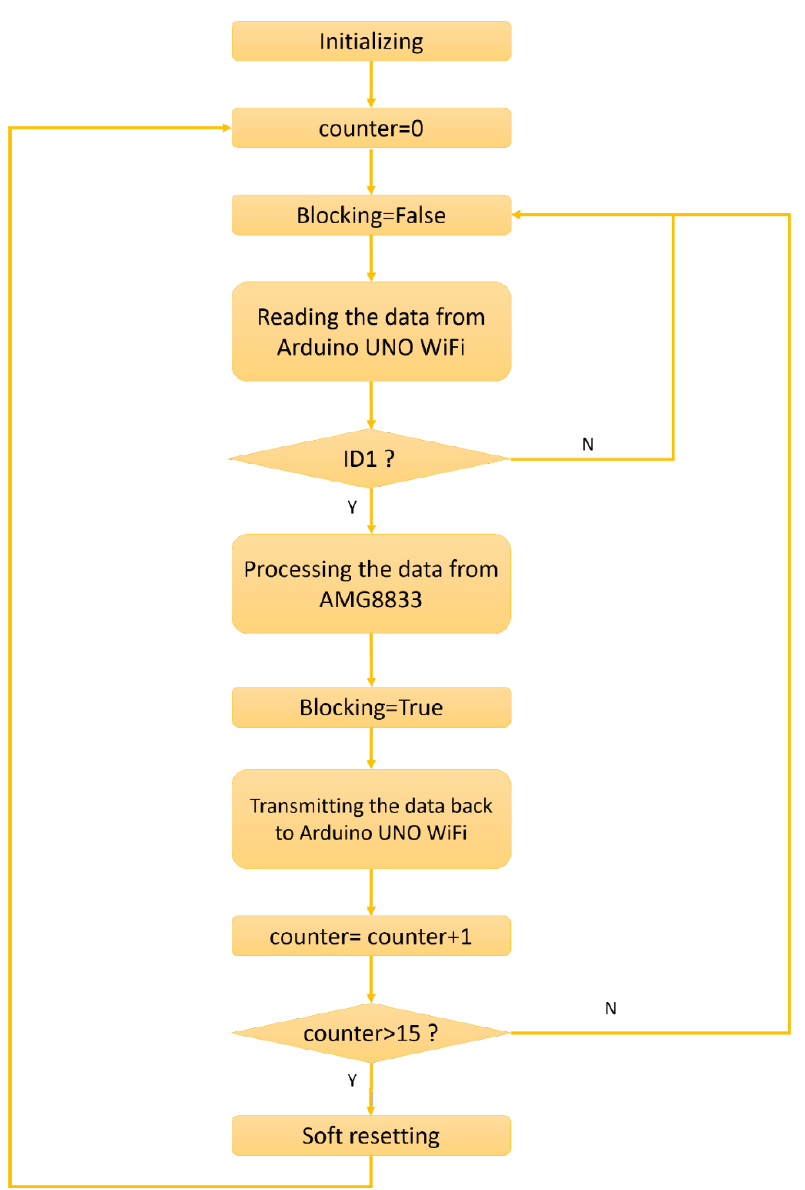
Figure 5. Execution flowchart of WiPy 3.0 named ‘ID1’.